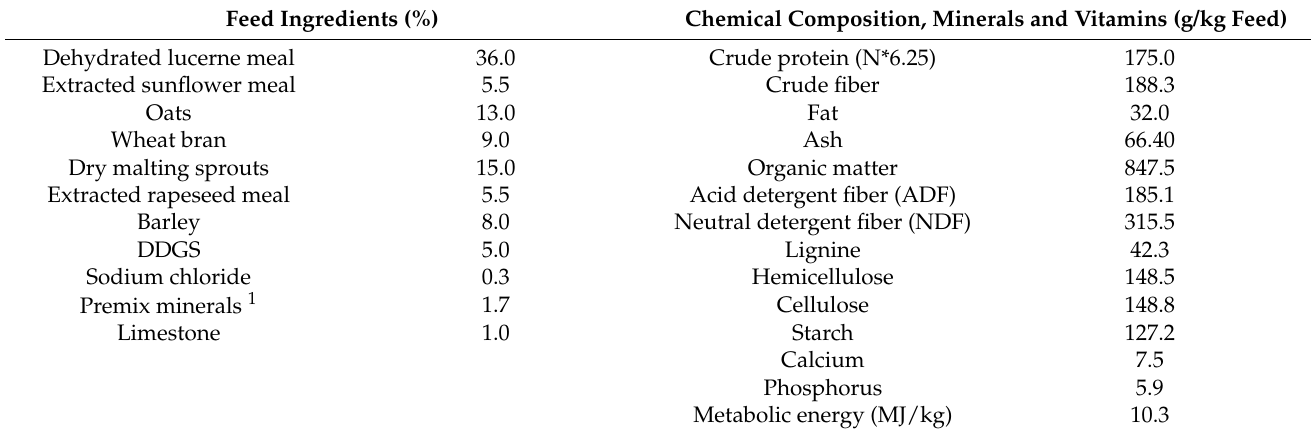
Table 1. Composition and ingredients of the basal